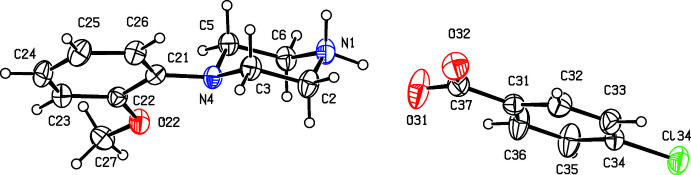
The independent components of compound (I) showing the atom-labelling scheme. Displacement ellipsoids are drawn at the 30% probability level.